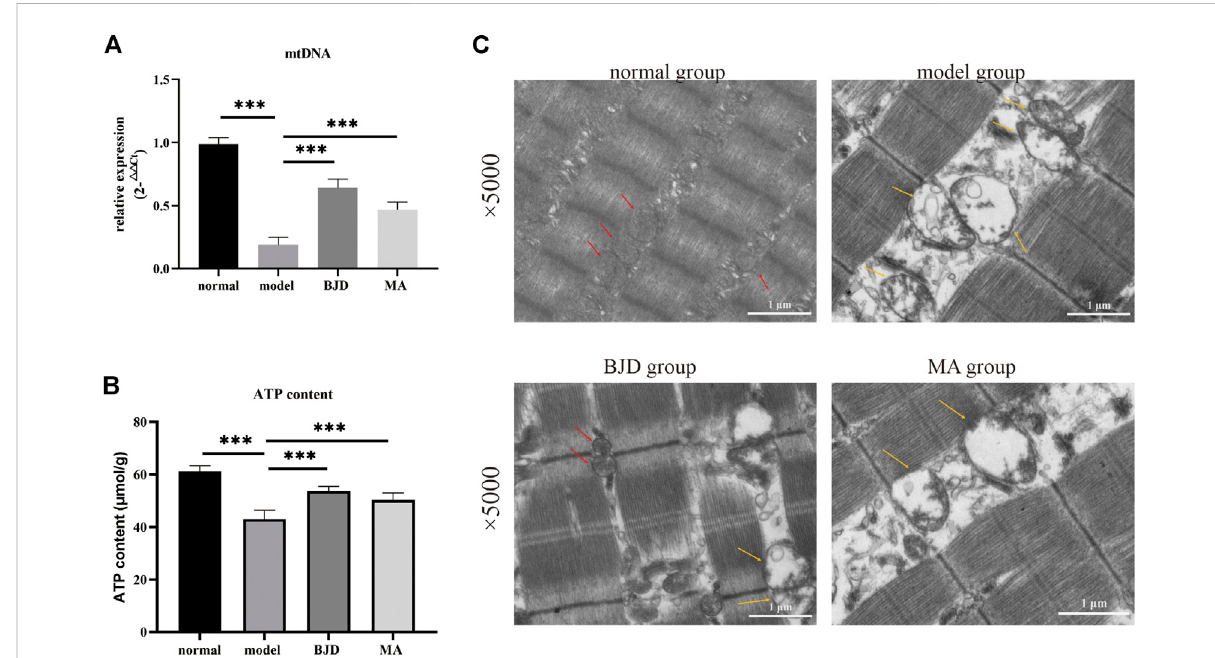
BJD promoted mitochondrial function in Apc Min/+ mice. (A) mtDNA was detected by qPCR, with ß -actin used as an internal gene; (B) ATP content was detected using the colorimetric method; and (C) mitochondrial morphology using transmission electron microscopy (×5.0 k).